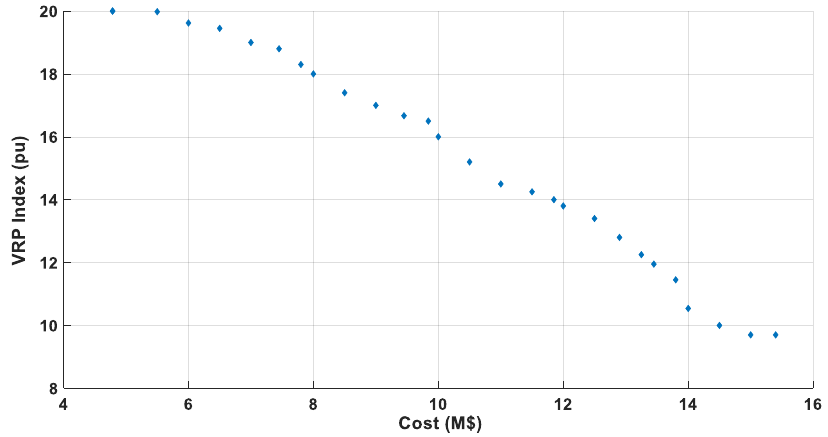
Figure 20. Optimal pareto solution for 33-bus system.